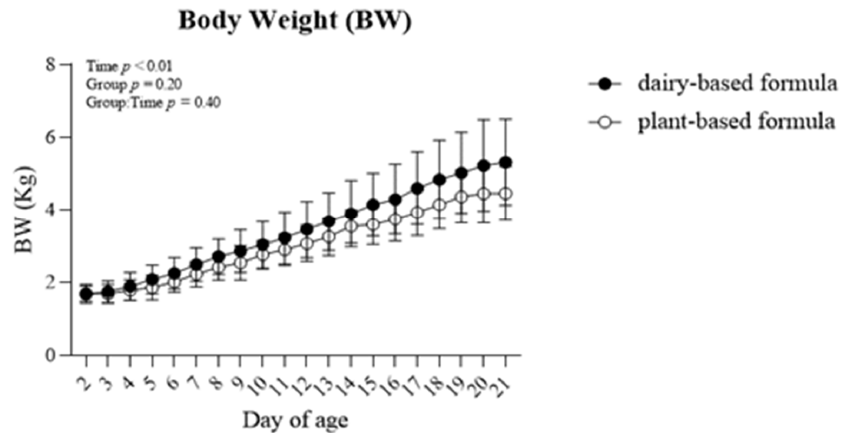
Figure 1. Average body weight (BW; Kg) per day of piglets fed either a dairy-based (Similac Advance powder) or a plant-based (Else nutrition powder) formula ( n = 9/group) from postnatal day (PND) 2 until PND 21.